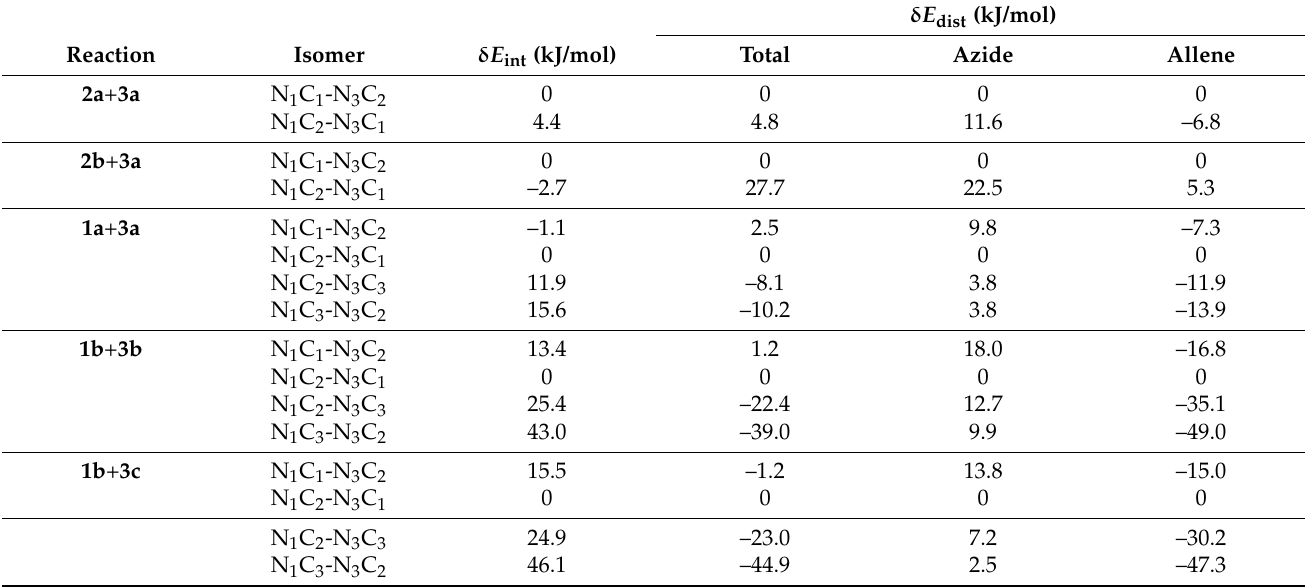
Table 6. Energy decomposition of the isomeric TSs calculated using the M08-HX functionals. The interaction and distortion energies are given relative to the major isomer so that a positive δ E is an unfavourable energetic contribution.